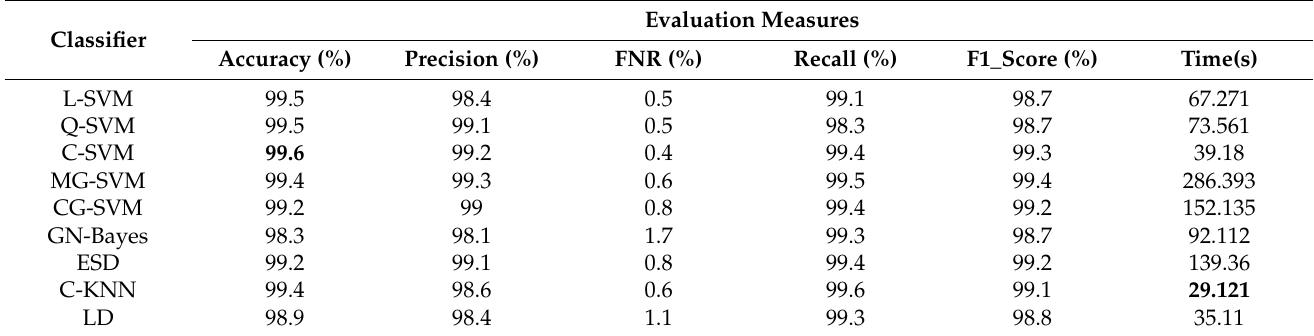
Table 3. Stomach disease classification with proposed feature optimization technique (CV =